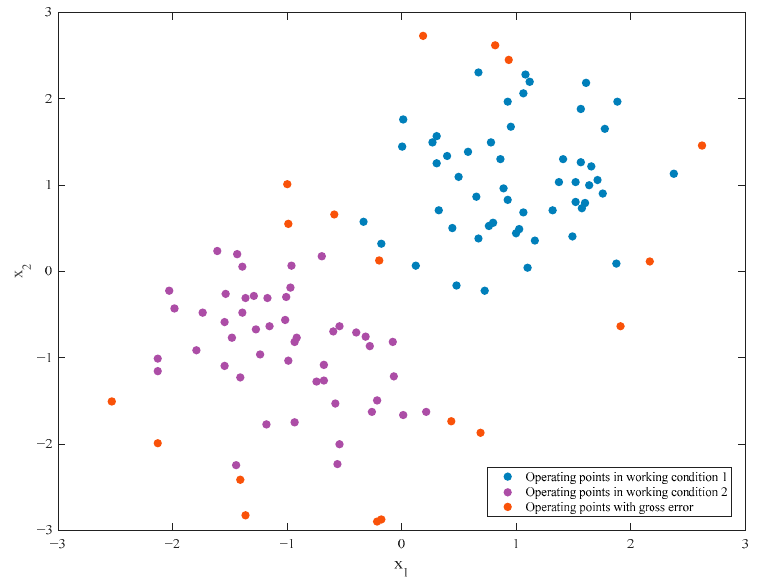
Figure 3. Distribution of the generated dataset.